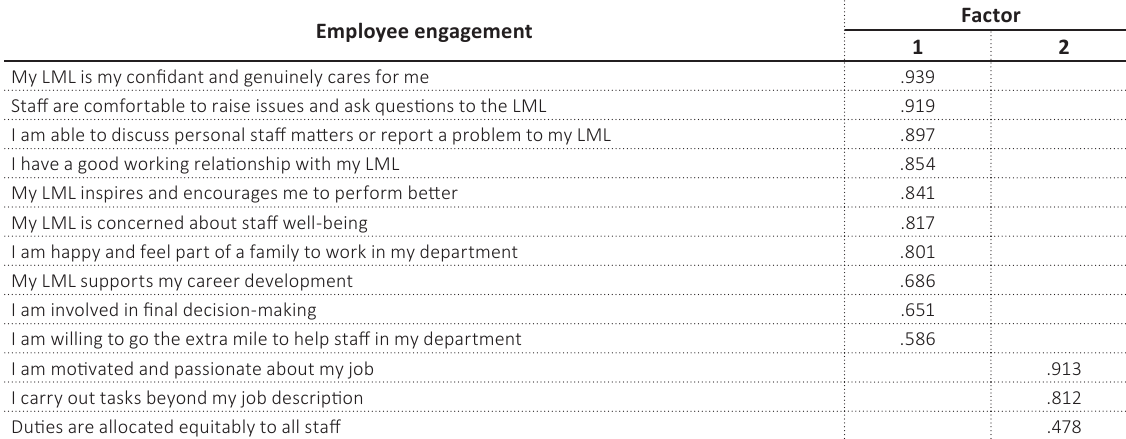
Table 2. Pattern matrix for employee engagement